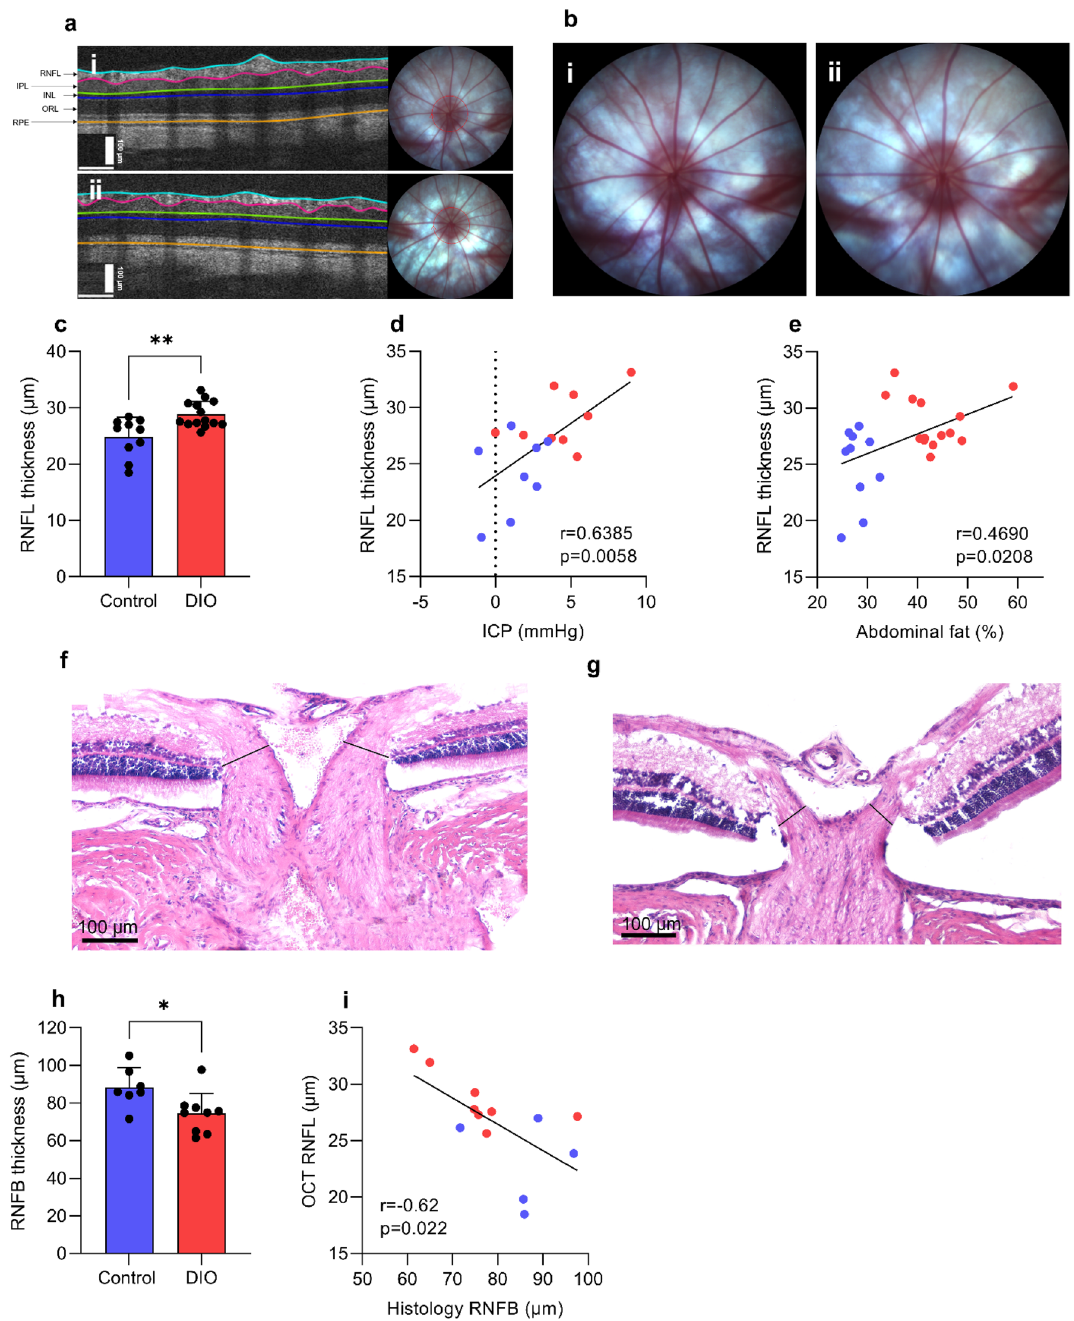
Figure 4. DIO and non-traumatic increased ICP alter neuroretinal structures. ( a ) Horizontally aligned OCT B-scans covering the peripapillary part circumferentially to the optic disc with manually adjusted segmentation lines in DIO (i) and control (ii) rats. ( b ) Optic disk photo in a DIO ( i ) and control animal (ii). ( c ) RNFL thickness between DIO and control. ( d ) Scatter graph showing a association between RNFL thickness and mean ICP on day 3. ( e ) Scatter graph showing association between RNFL thickness and abdominal fat-%. RNFB thickness in the prelaminar region of the ONH in a control animal ( f ) and a DIO animal ( g ) showing measure points (black solid lines). ( h ) Thickness of the RNFB. ( i ) Scatter graph showing correlation between OCT RNFL and histological RNFB. RNFL retinal nerve fiber layer, IPL inner plexiform layer, INL inner nucleus layer, ORL outer retinal layers (including outer plexiform layer, outer nucleus layer, inner segments and outer segments) and RPE retinal pigment epithelium. Data in ( c,h ) are presented as mean + SD. Unpaired T-test for ( c,h ), Pearson’s correlation for ( d,e,i ). *P < 0.05, **P <